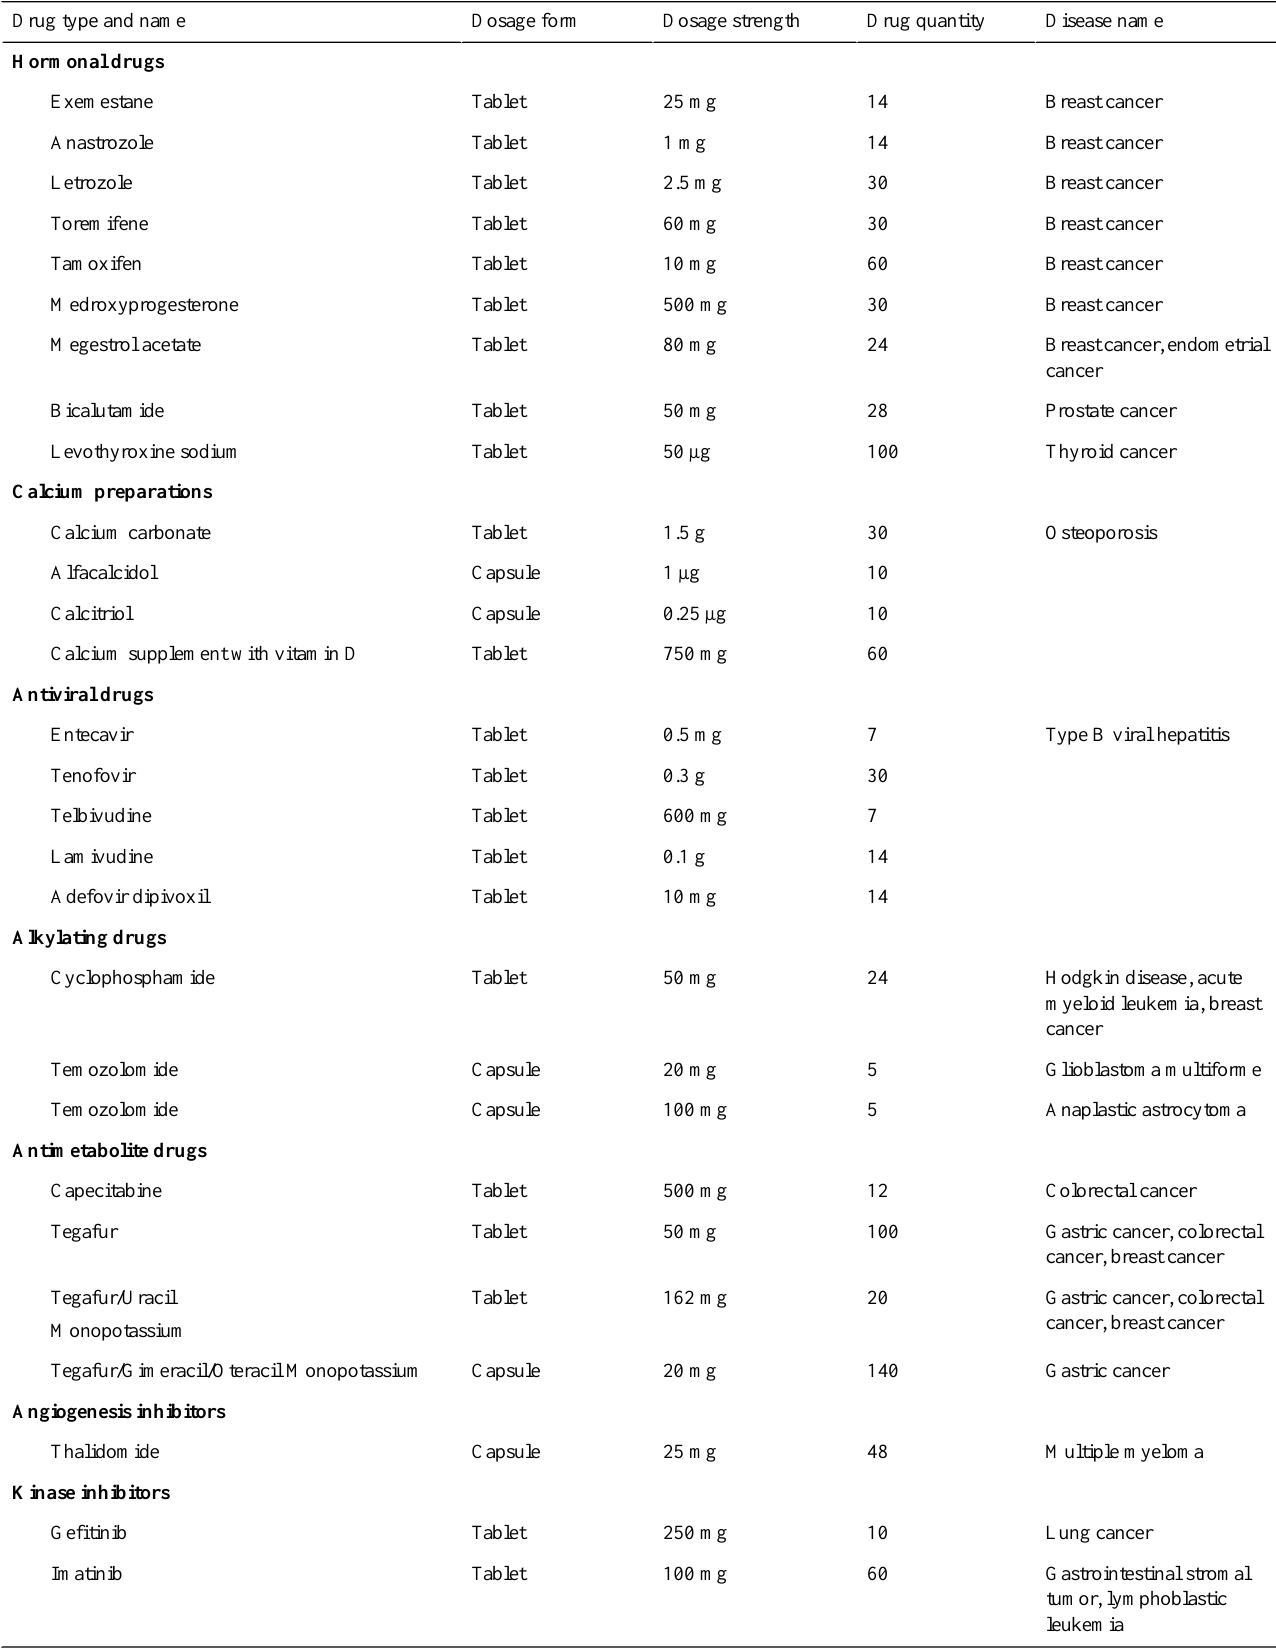
Table 1. Anticancer drugs (n=22) and adjuvant medicines (n=9) listed in the Cloud SYSUCC